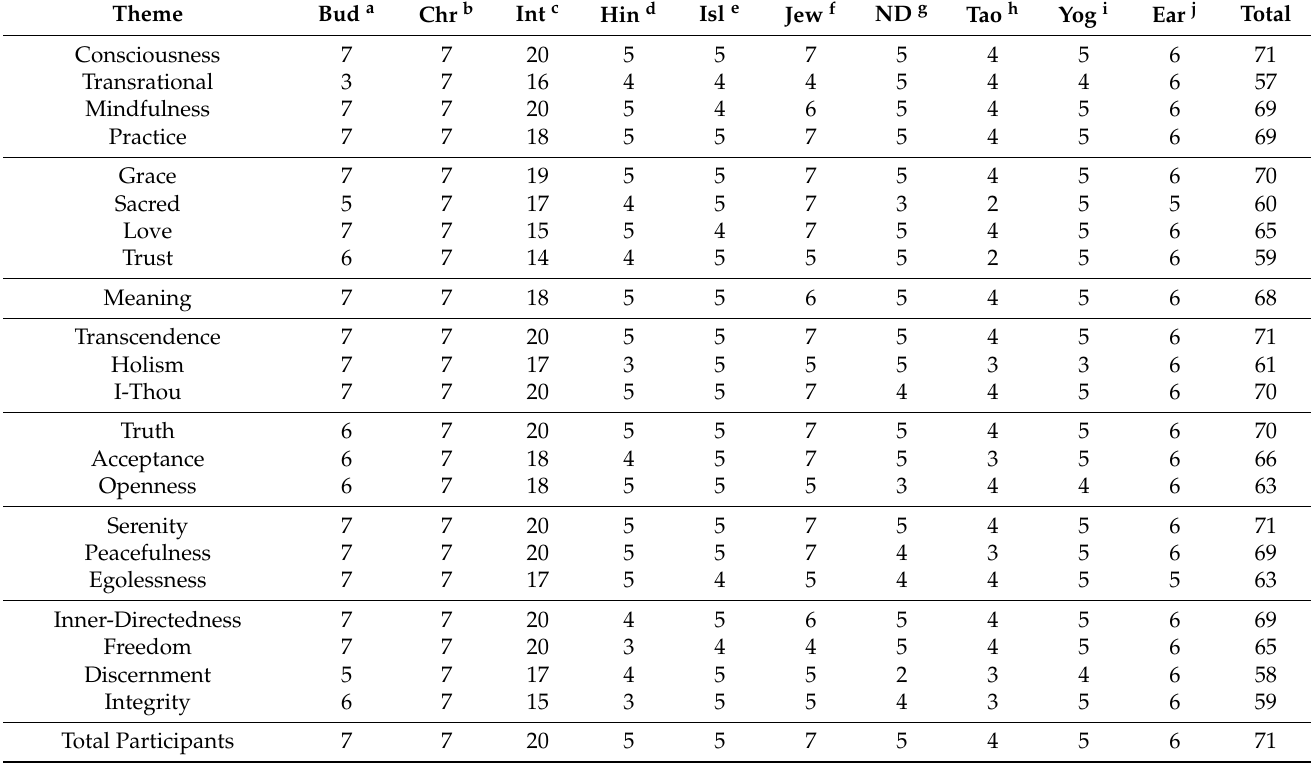
Table A1. Major Themes and Sub-Themes Presented by Participants from Each Tradition (N =